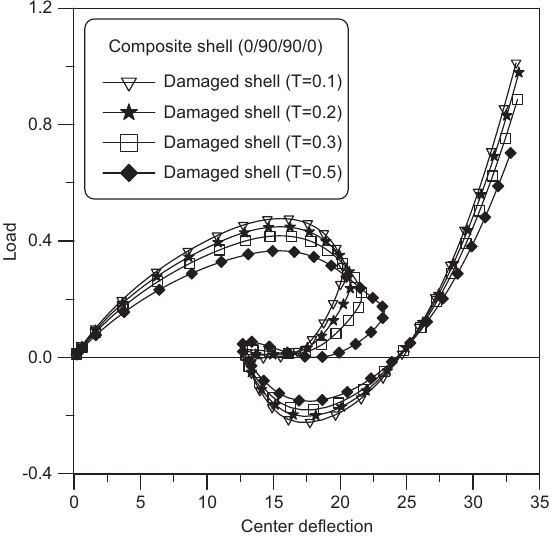
Figure 20 Load-displacement curves of hinged cylindrical shell.